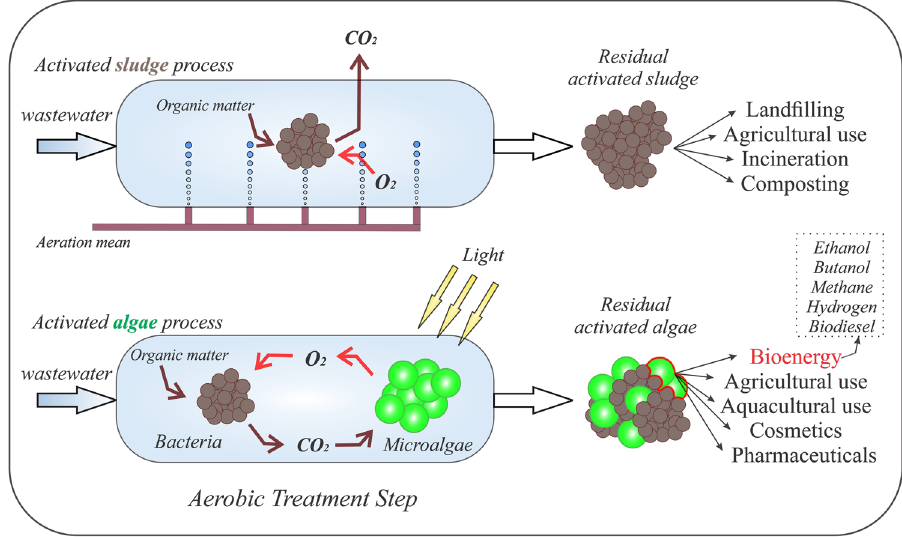
Figure 1. Microalgae-based technology for aerobic wastewater treatment. Economic and ecologic advantages that could be obtained by implementing activated algae-based technology in comparison with the conventional activated sludge process. Aerobic processes could occur in the activated algae system without mechanical aerations means as the oxygen is generated through photosynthesis processes, released CO 2 during wastewater treatment is used in photosynthesis by microalgae, and residual microalgae biomass could be used in a wide range of applications. In comparison, aerobic wastewater treatment using activated sludge requires a significant amount of energy for oxygen generation, causes the release of the greenhouse gas such as CO 2 , and capitalization of the residual activated sludge is limited by legislative norms 41